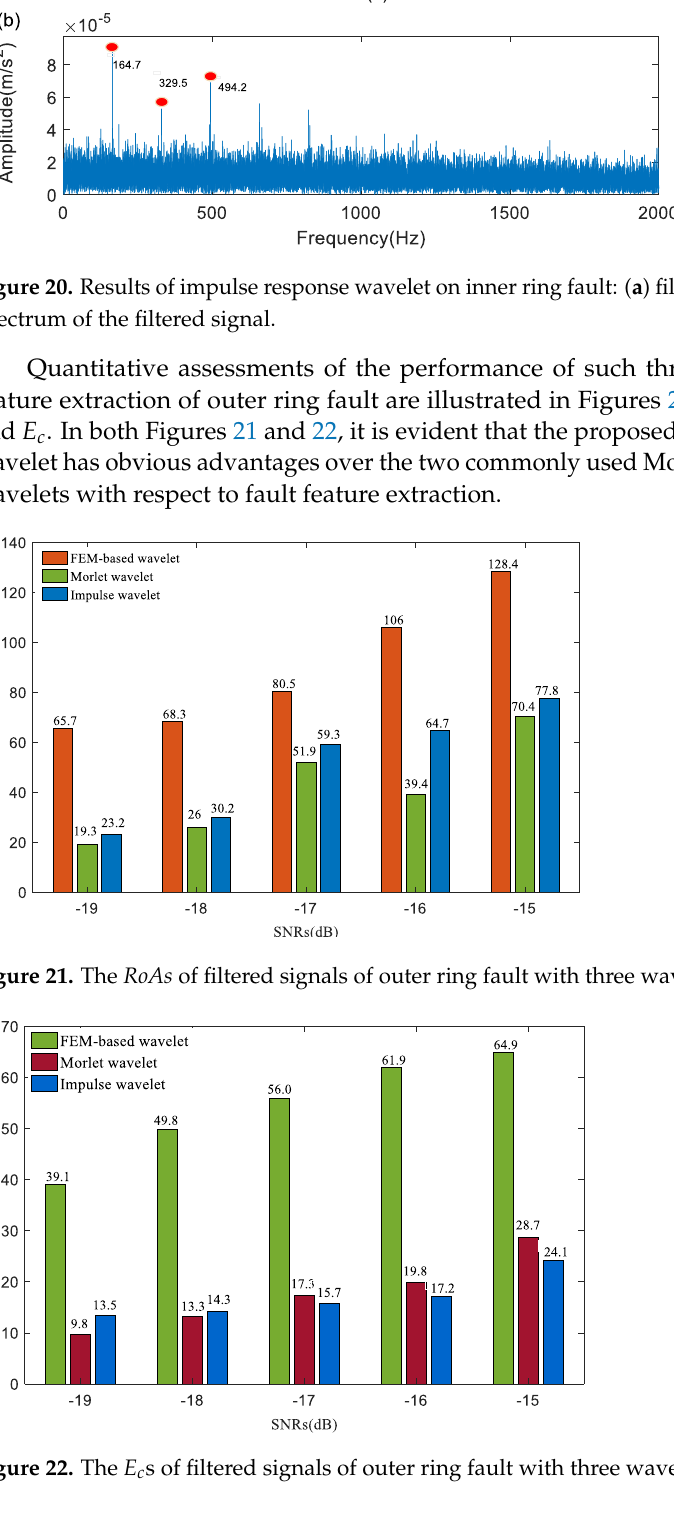
Figure 22. The E c s of filtered signals of outer ring fault with three wavelet bases at different SNRs.